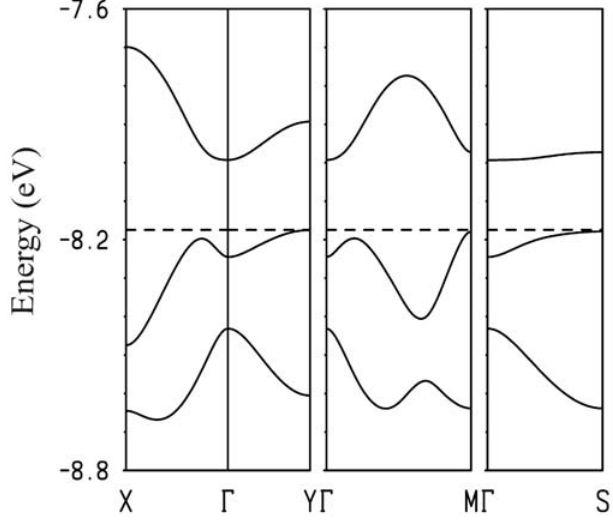
Figure 3. Band structure calculated for a donor layer of β "-(BEDT-TTF) dashed line refers to the highest occupied level. Γ = (0, 0), X = ( a */2, 0), Y = (0. b */2), M = ( a */2, b */2) and S = (- a */2, b */2).